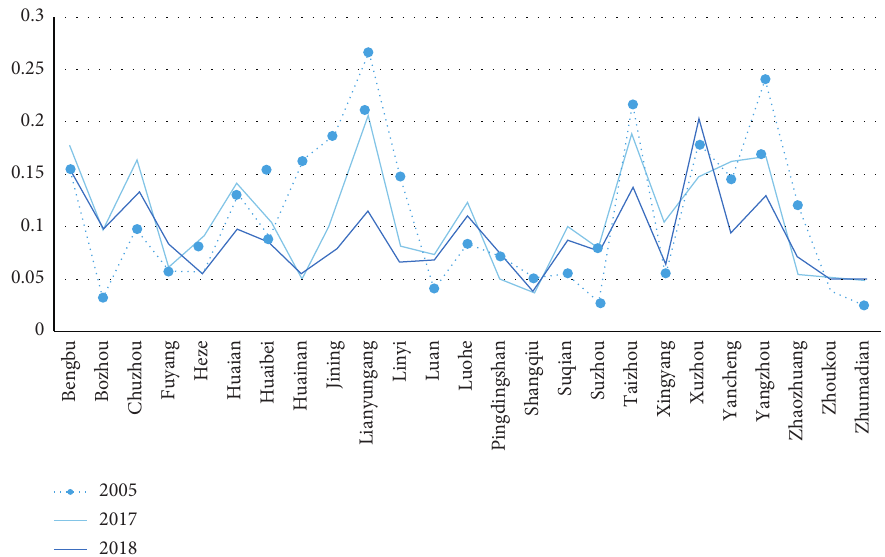
Figure 2: Comparison of innovation efficiency competitiveness of some cities over the years.